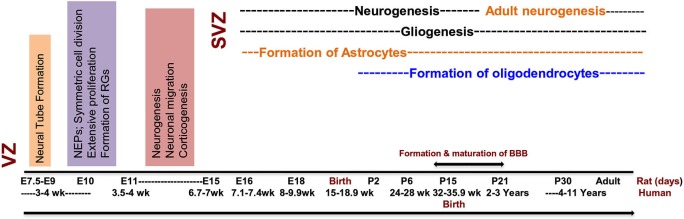
Schematic representation of various cell types generated along the VZ and SVZ in embryonic and postnatal life with a comparison of various developmental milestones in rat and human brain. NEPs = Neuroepithelial cells; RGs = Radial glial cells; SVZ = Subventricular Zone; VZ = Ventricular Zone; wk = Week; BBB = Blood Brain Barrier.